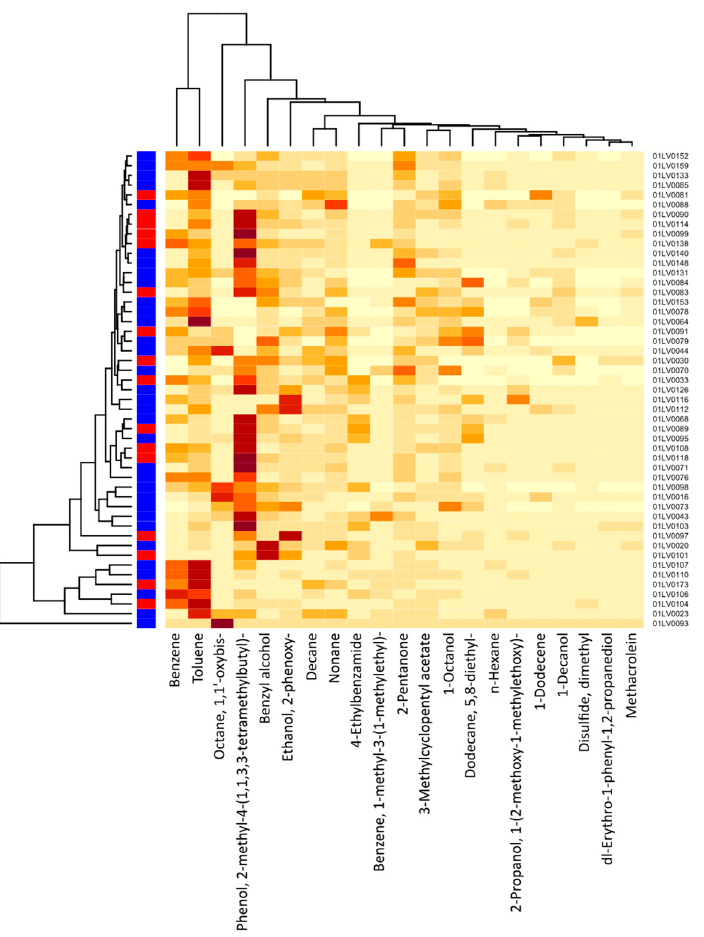
Figure 4. Cluster heatmap of breath VOC levels for each study participant (21 VOCs and 49 participants). The x -axis depicts the respective breath VOCs and the y -axis, the patient IDs. Red color on the left vertical axis indicates gastric cancer cases, whereas blue color indicates healthy controls. The darker-colored cells indicate higher concentrations of metabolites, and lighter-colored cells represent lower concentration levels for each subject. The intensity of color corresponds to the concentration levels of VOCs.